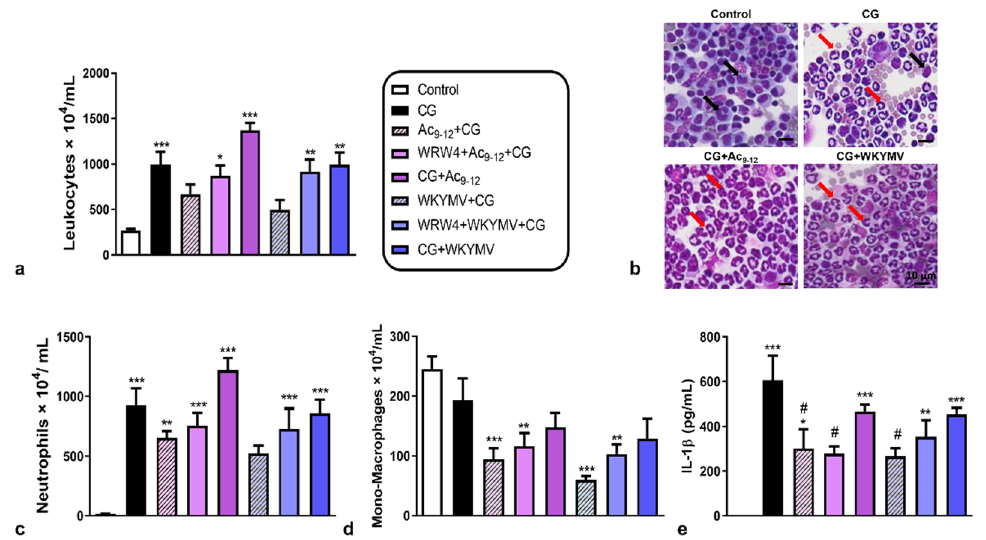
Figure 1. Effect of Ac 9-12 and WKYMV peptides in carrageenan-induced peritonitis. ( a ) Quantifica- tion of leukocytes in peritoneal wash. ( b ) Representative images from peritoneal wash from control, carrageenan (CG), CG pre- or post-treated with Ac 9-12 (CG+Ac 9-12 ), or with WKYMV (CG+WKYMV), CG pre-treated with WRW4+ Ac 9-12 or WRW4+WKYMV groups. Monocytes (black arrows). Neutrophils (red arrows). Stain: Diff-Quick. ( c ) Neutrophils. ( d ) Mononyctes (Mono)-Macrophages. ( e ) Peritoneal IL-1 β levels. Data represent the mean ± S.E.M. of cell numbers × 10 4 /mL or IL-1 β levels (pg/mL) ( n = 6–7 animals/group). * p < 0.05, ** p < 0.01, *** p < 0.001 vs. control; # p < 0.05 vs. CG (ANOVA, Bonferroni